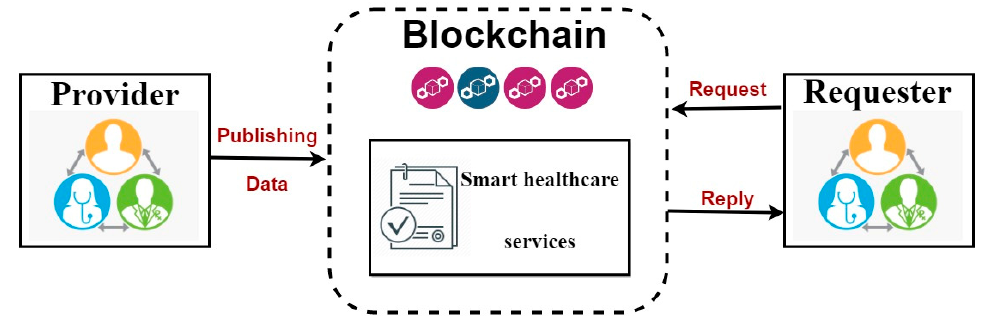
Figure 2. Smart healthcare services.